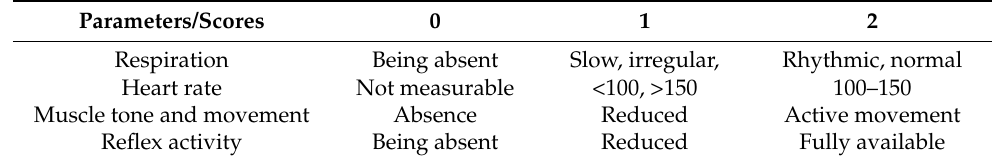
Table 3. Modification of Mülling’s Apgar score system by Maurer-Schweizer et al. [76]. Parameters/Scores 0 1 2 Respiration Being absent Slow, irregular, Rhythmic, normal Heart rate Not measurable <100, >150 100–150 Muscle tone and movement Absence Reduced Active movement Reflex activity Being absent Reduced Fully available